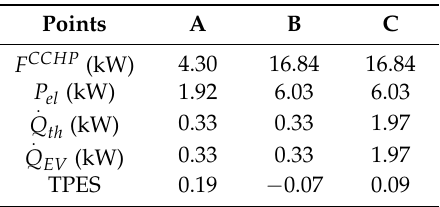
Table 8. The trigeneration primary energy saving (TPES) values calculated for the operating points of the CCHP